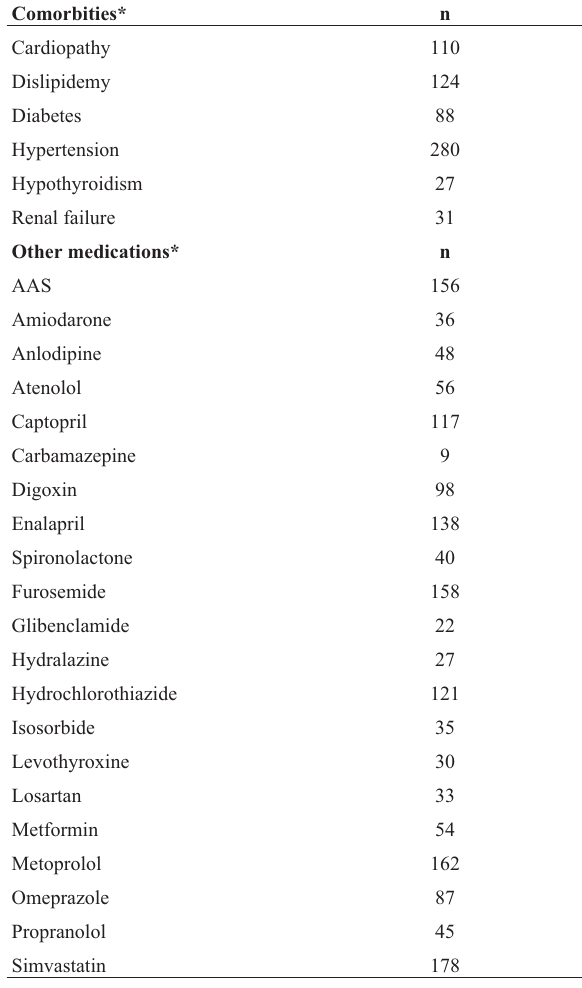
Table 2 - Comorbidities and co-medications of patients included in the in- vestigated